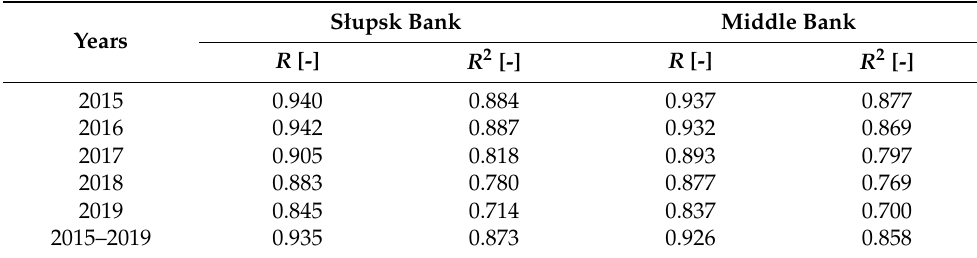
Table 8. Correlation between average monthly values of demand and generation in OWF.